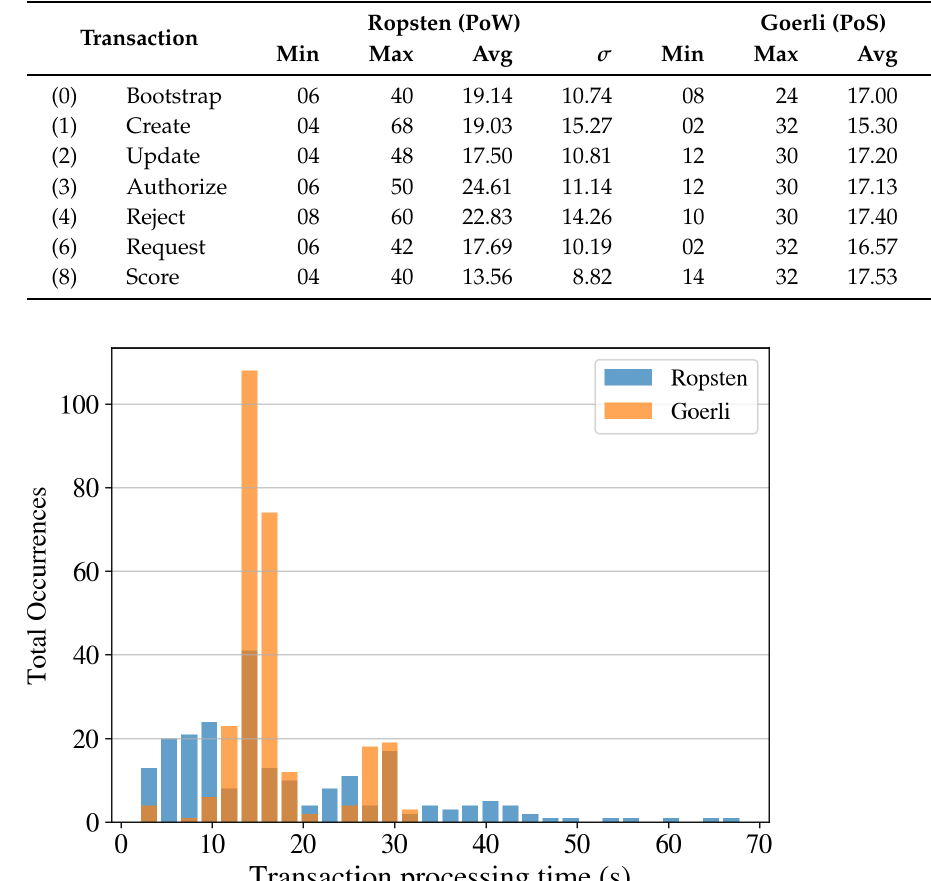
Table 5. Create transaction processing times in terms of minimum, maximum, average, and variation on a Ropsten and a Goerli network.